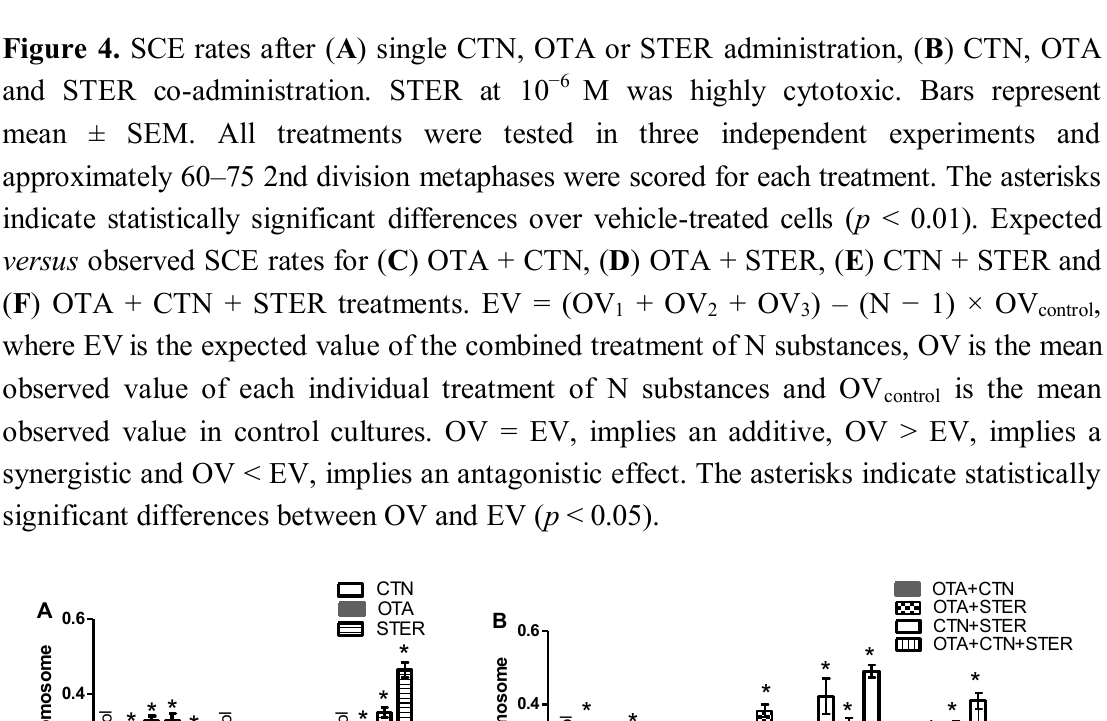
Figure 4. SCE rates after ( A ) single CTN, OTA or STER administration, ( B ) CTN, OTA and STER co-administration. STER at 10 −6 M was highly cytotoxic. Bars represent mean ± SEM. All treatments were tested in three independent experiments and approximately 60–75 2nd division metaphases were scored for each treatment. The asterisks indicate statistically significant differences over vehicle-treated cells ( p < 0.01). Expected versus observed SCE rates for ( C ) OTA + CTN, ( D ) OTA + STER, ( E ) CTN + STER and ( F ) OTA + CTN + STER treatments. EV = (OV